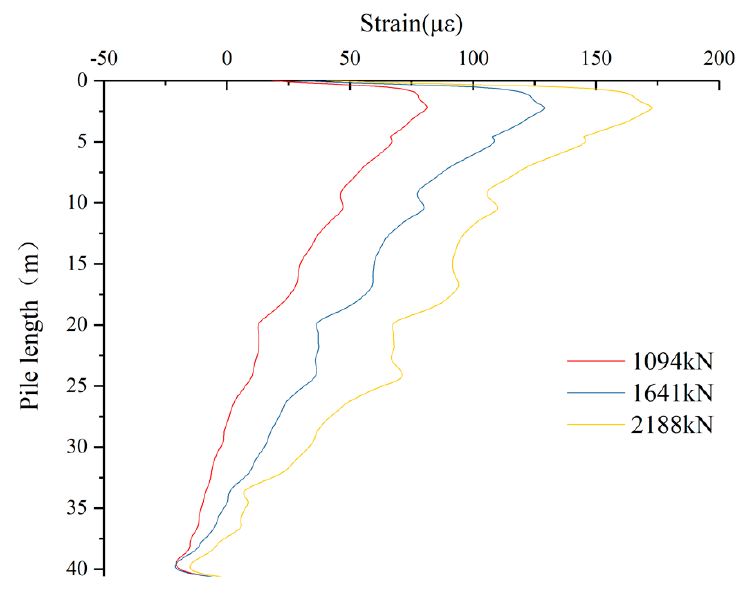
Figure 8. Final strain curves under three loads.